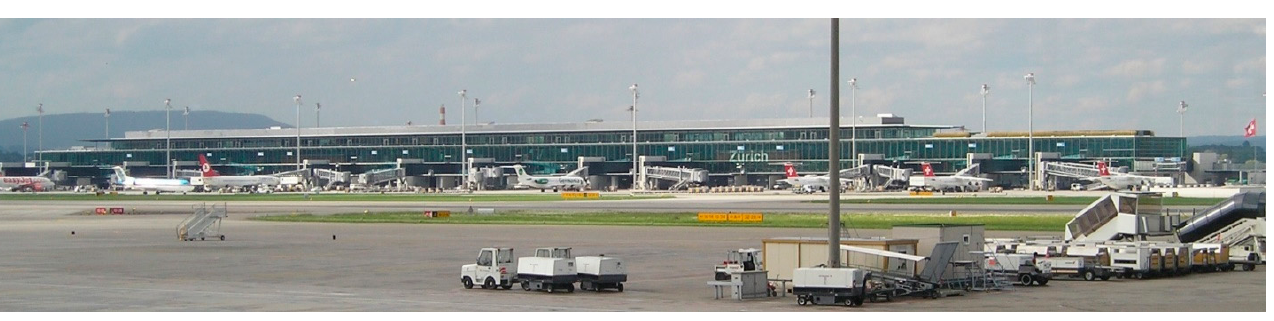
Figure 20. Zurich Airport, Midfield Terminal E. Details: 200,000 m 3 construction space, 58,000 m 2 energy supply area, 2120 MWh/a heating, 1240 MWh/a cooling load; 300 energy piles 30 m long. Construction from 1997 to 2001.